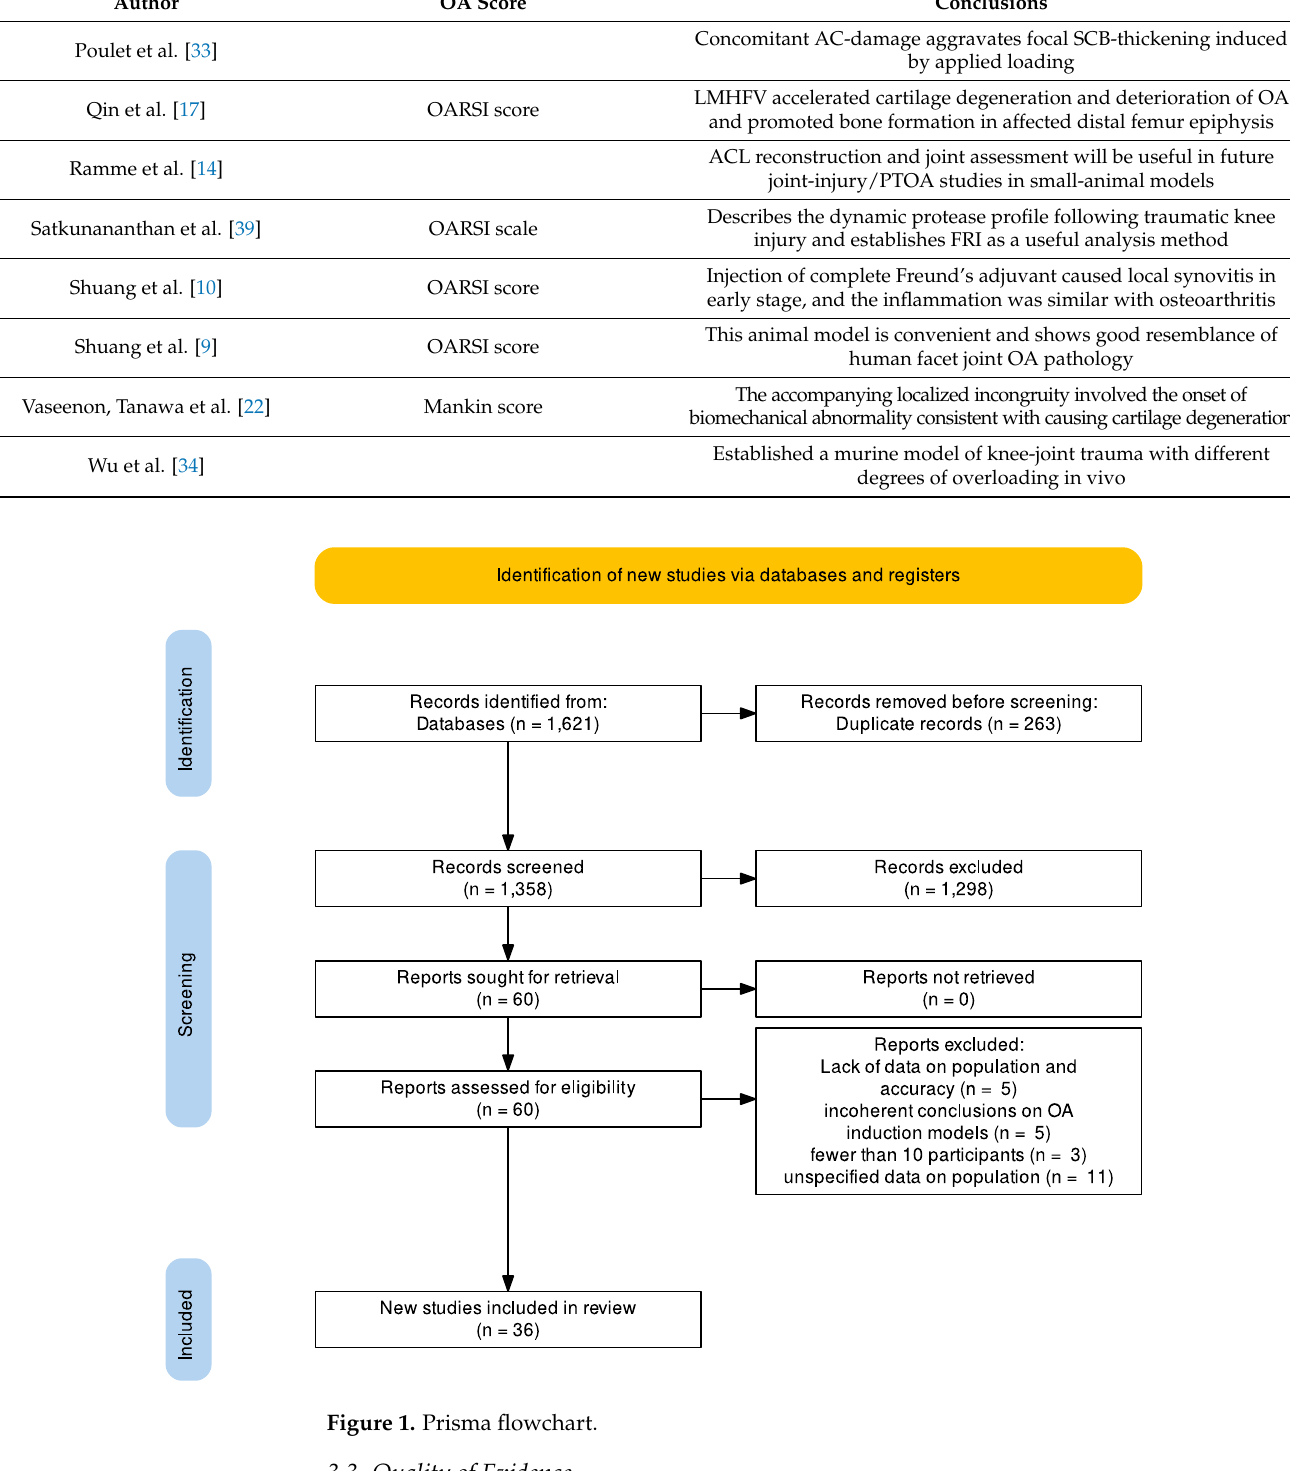
Table 1. Study characteristics . Author